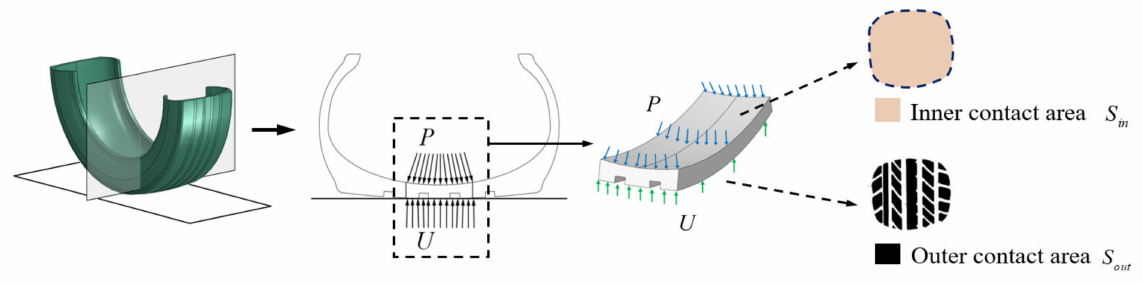
Figure 1. Tire–road contact